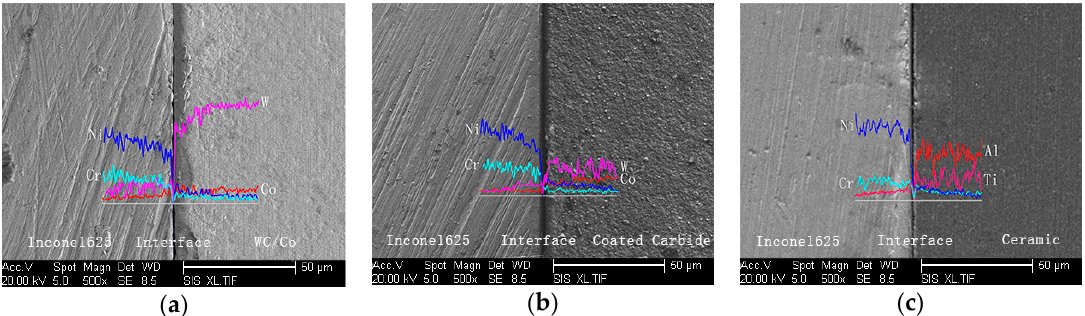
Figure 9. Line scan of the tool materials and Inconel 625 at 873 K. ( a ) WC/Co, ( b ) coated carbide, and ( c ) ceramic.